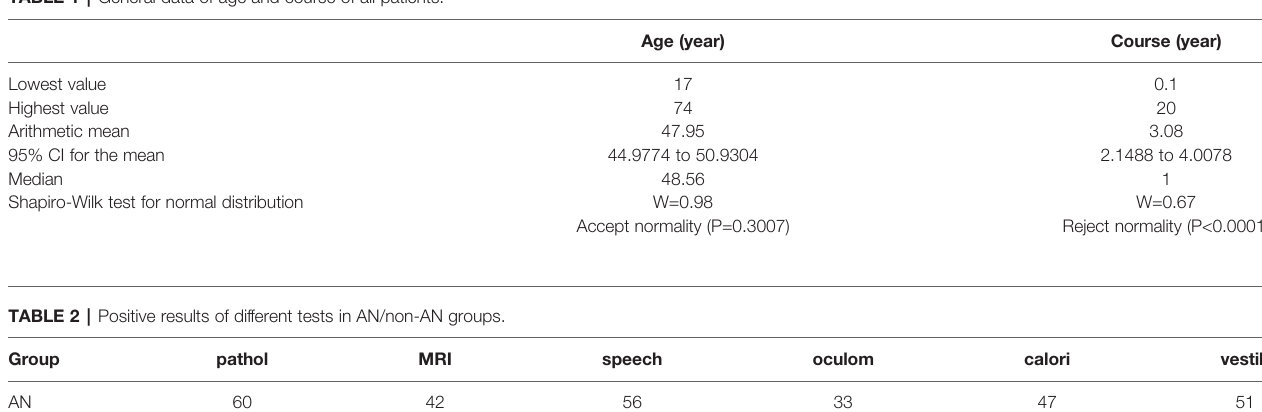
TABLE 1 | General data of age and course of all patients.